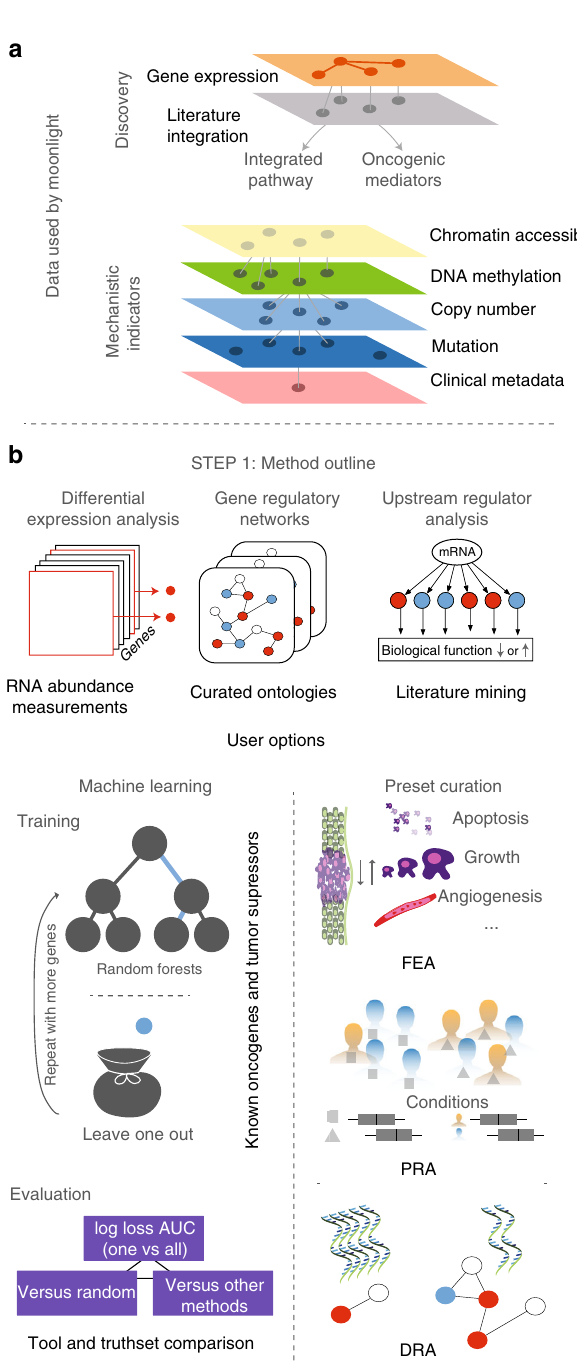
Fig. 1 Moonlight data integration and functionalities. a Data used for discovery of oncogenic mediators and controlling mechanisms of cancer driver genes. b Moonlight pipeline for discovery of tumor suppressors, oncogenes, and dual-role